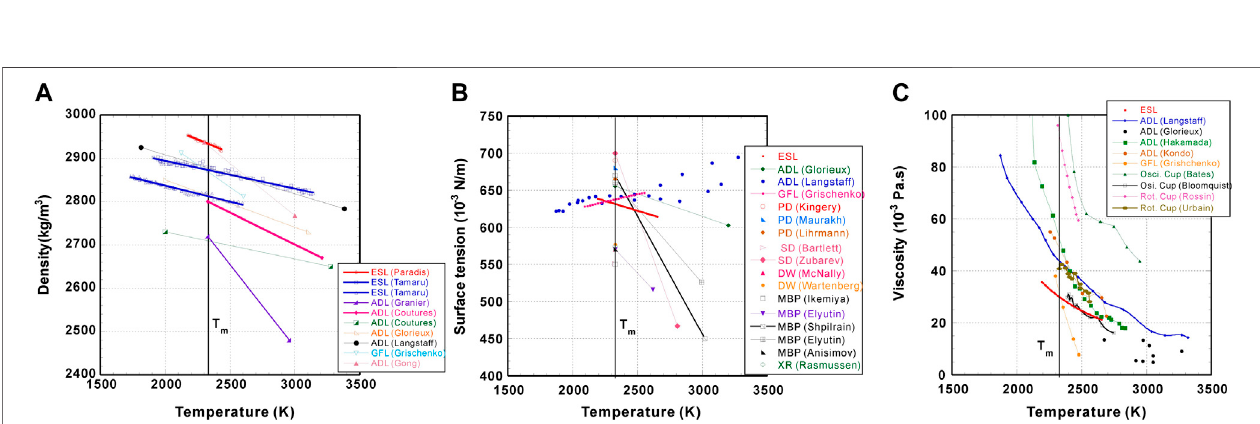
FIGURE 3 | Measured thermophysical properties of molten Al 2 O 3 vs. temperature: (A) Density; (B) Surface tension; (C) Viscosity. The correlation coef fi cient (R) of our measurements (ESL) is 0.98 for density, 0.43 for surface tension, and 0.61 for viscosity, respectively.